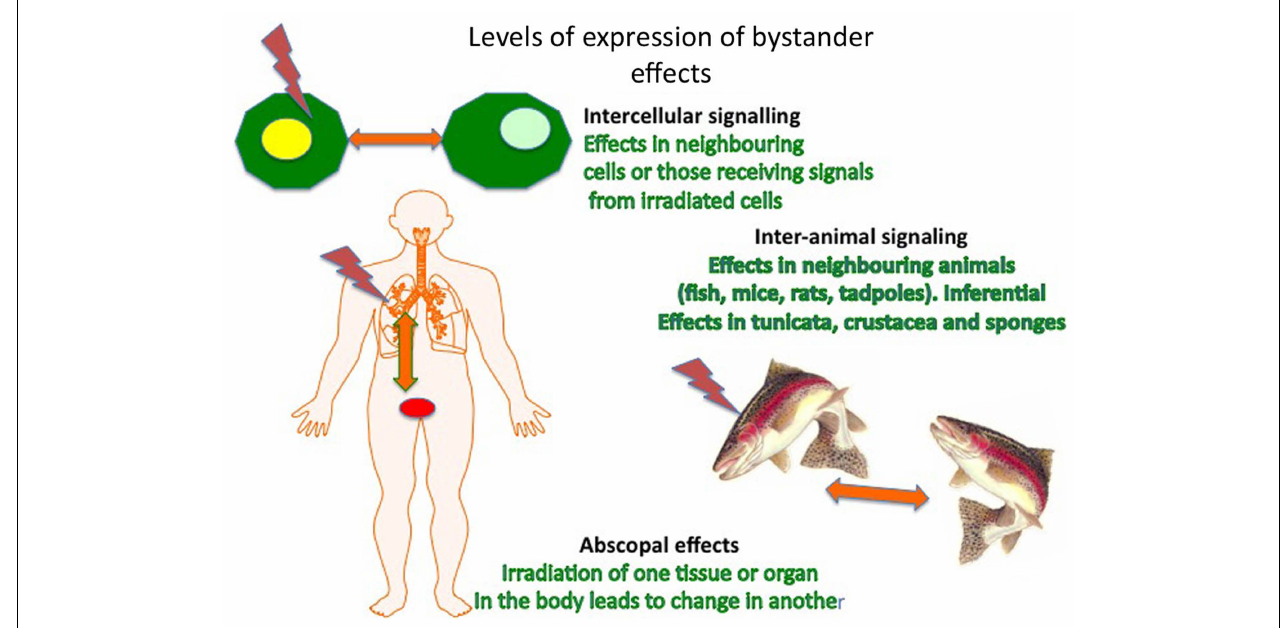
FIGURE 2 | Levels of expression of non-targeted effects in cells, organisms, and